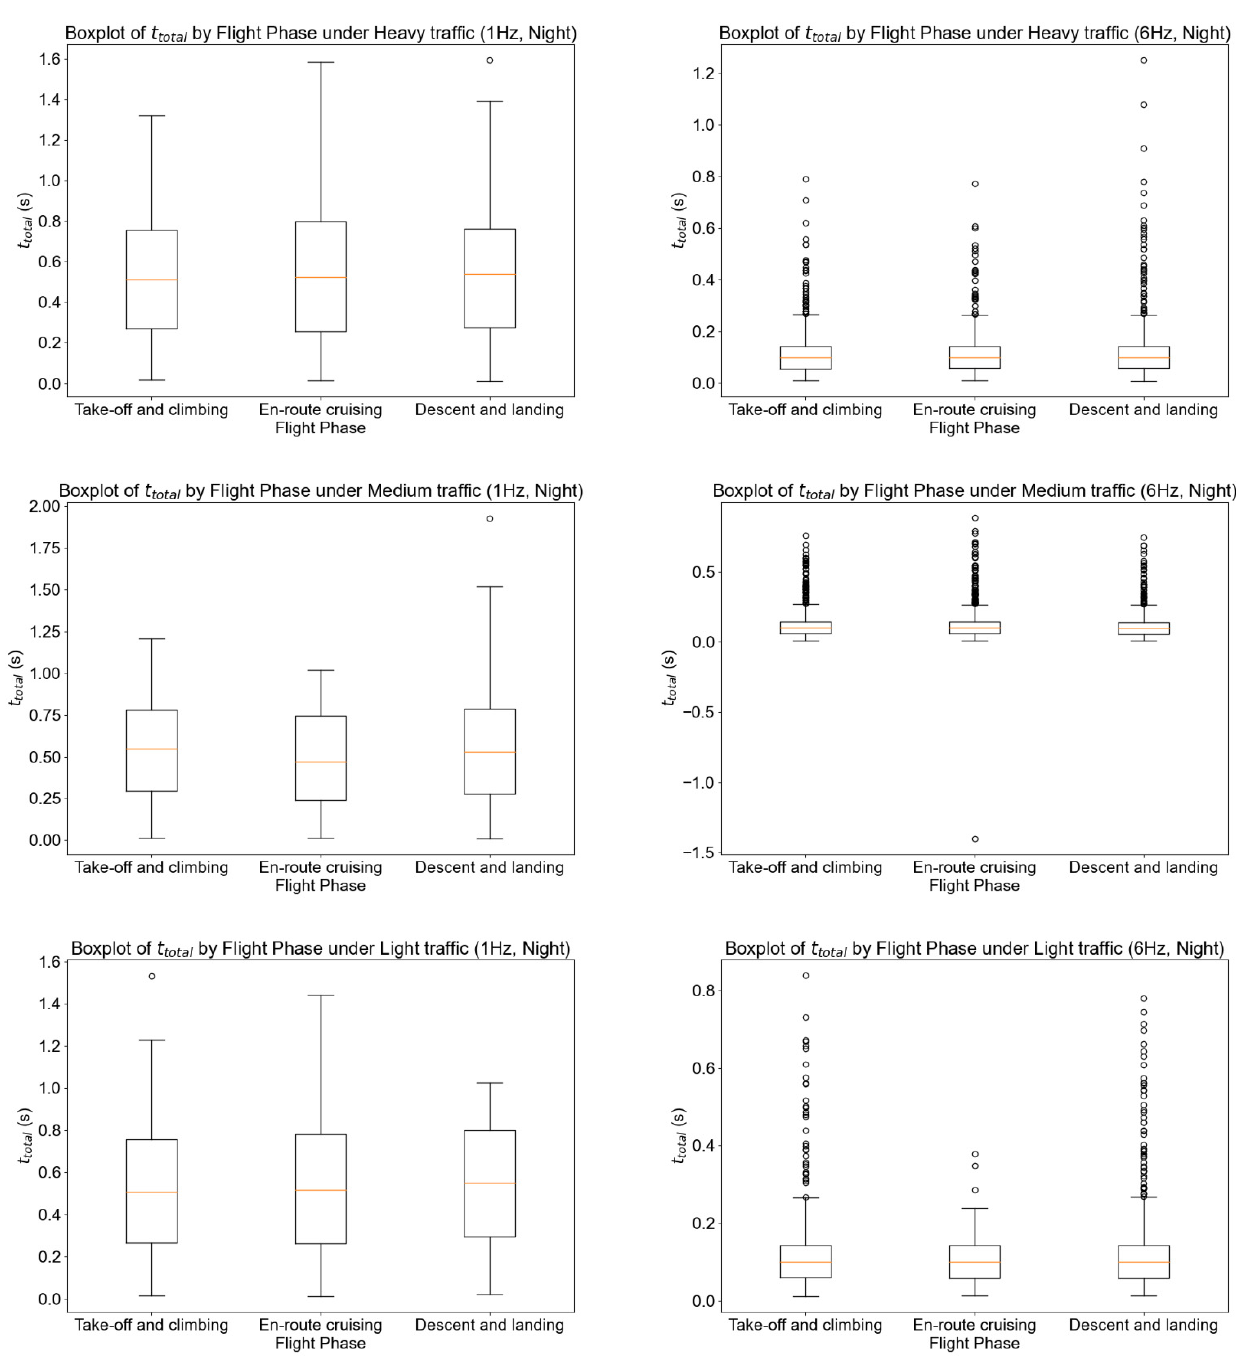
Figure A6. The boxplots of t total during night-time setting.